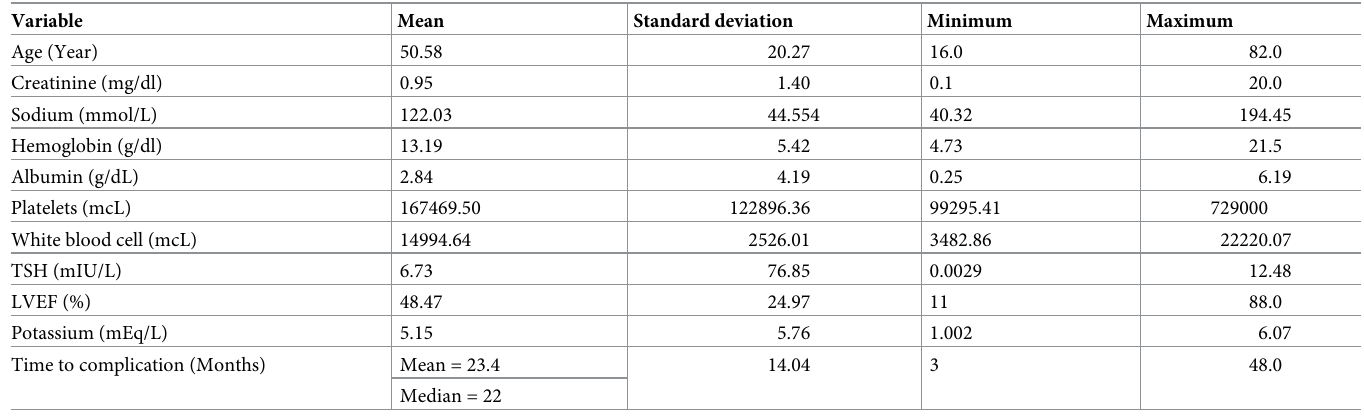
Table 3. Results of the descriptive statistics for continuous variables.